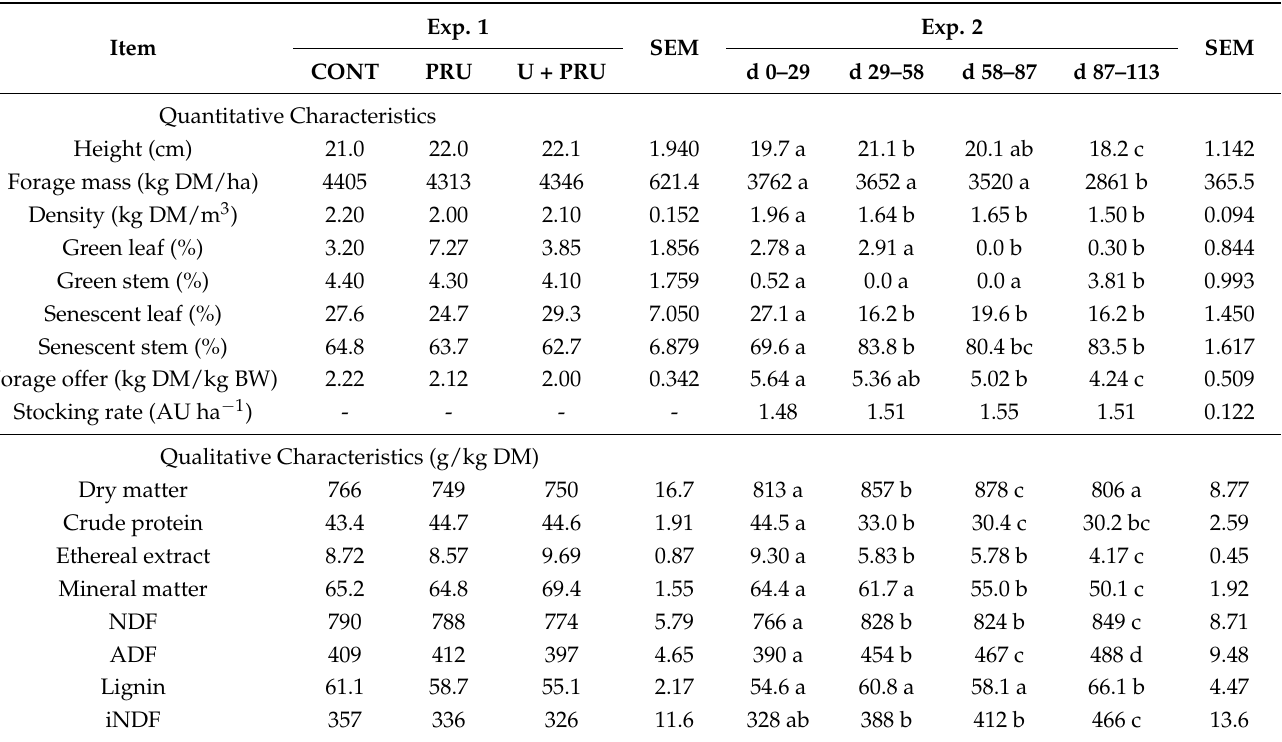
Table 2. Quantitative and qualitative characteristics of Urochloa brizantha cv. Marandu during the growing phase of Nellore steers and Nellore young bulls, supplemented with post-ruminal urea and conventional urea in the dry